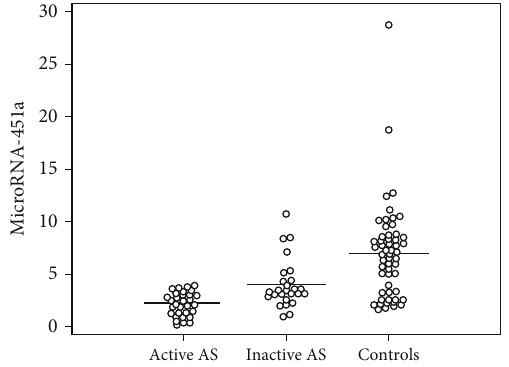
Figure 2: Comparison between the three studied groups according to microRNA-451a.